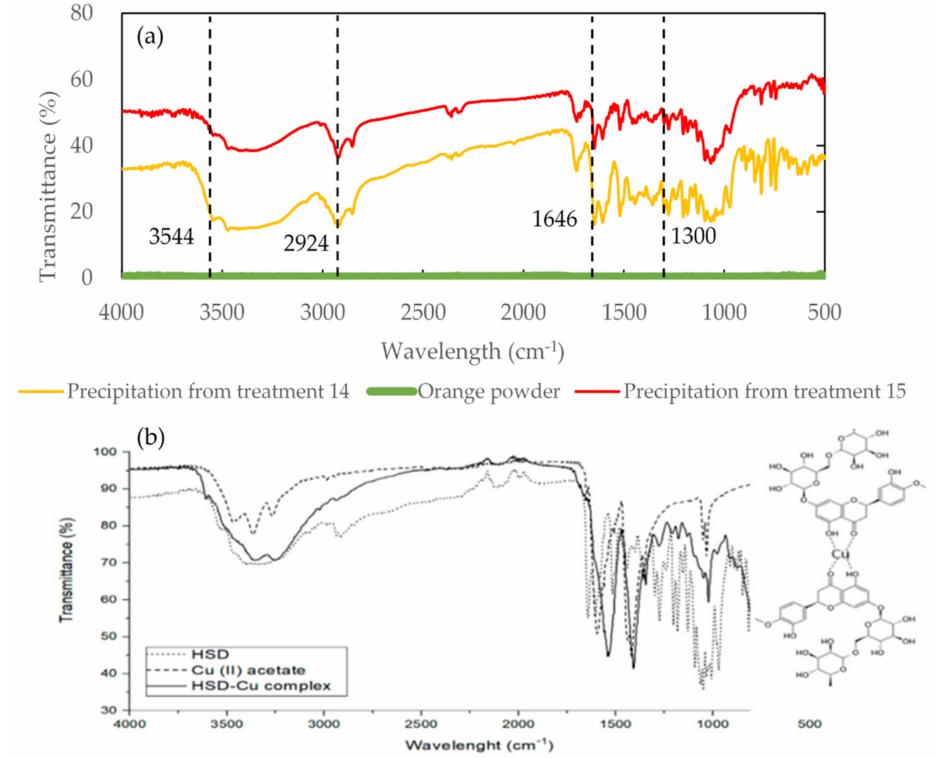
Figure 3. The transmittance of precipitation with different ultrasonic treatments mixed with potassium bromide detected by FTIR ( a ) and hesperidin–copper complex cited from the study of Stanisic et al. (2020) [41] ( b